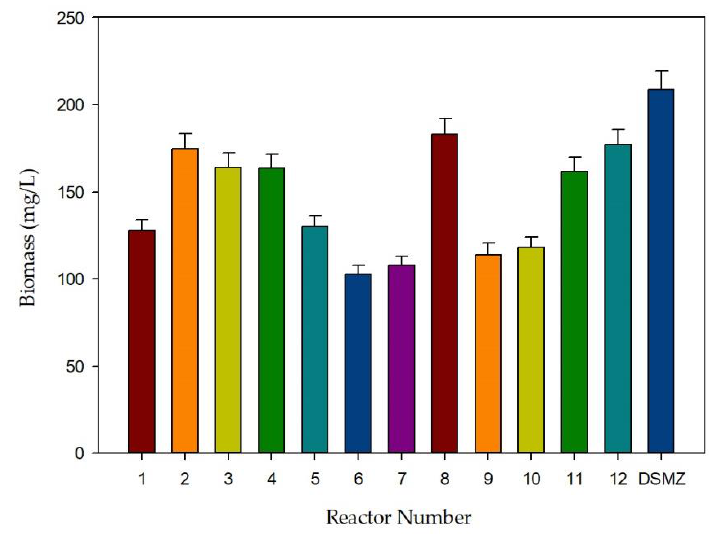
Figure 1. Biomass obtained in different experimental trials.